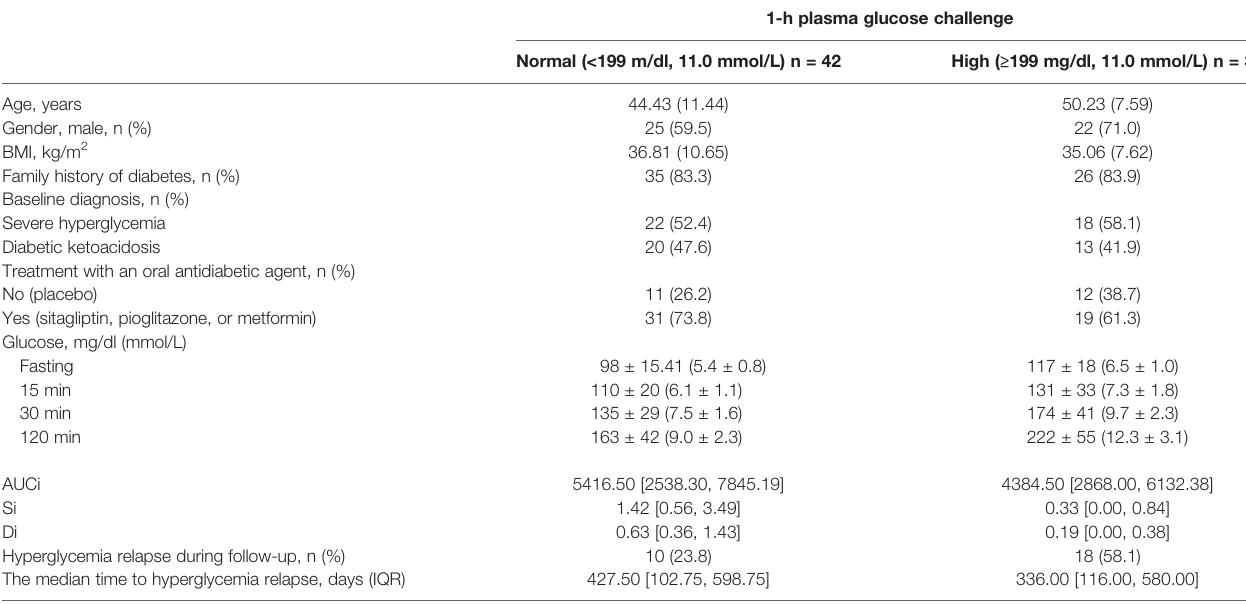
TABLE 2 | Baseline characteristics of the study population, strati fi ed according to 1-h plasma glucose challenge 199